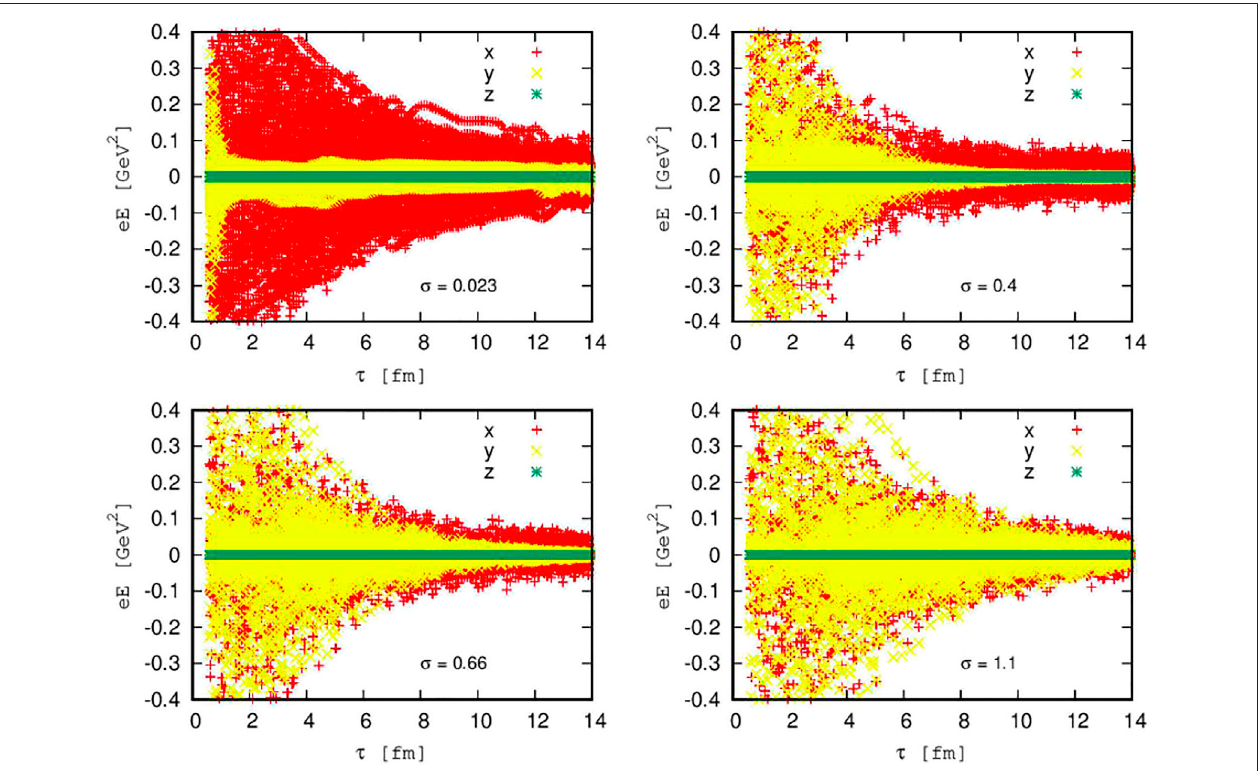
FIGURE 3| (Color online) The electric fi eld evolution created in asystem of relativistic heavy-ion collision after a Pb + Pb collision with 20 – 30% centrality at collision (cid:4) √ (cid:1) 2.76 ATeV on the choice of different electrical conductivity for the Maxwell equations. energy s